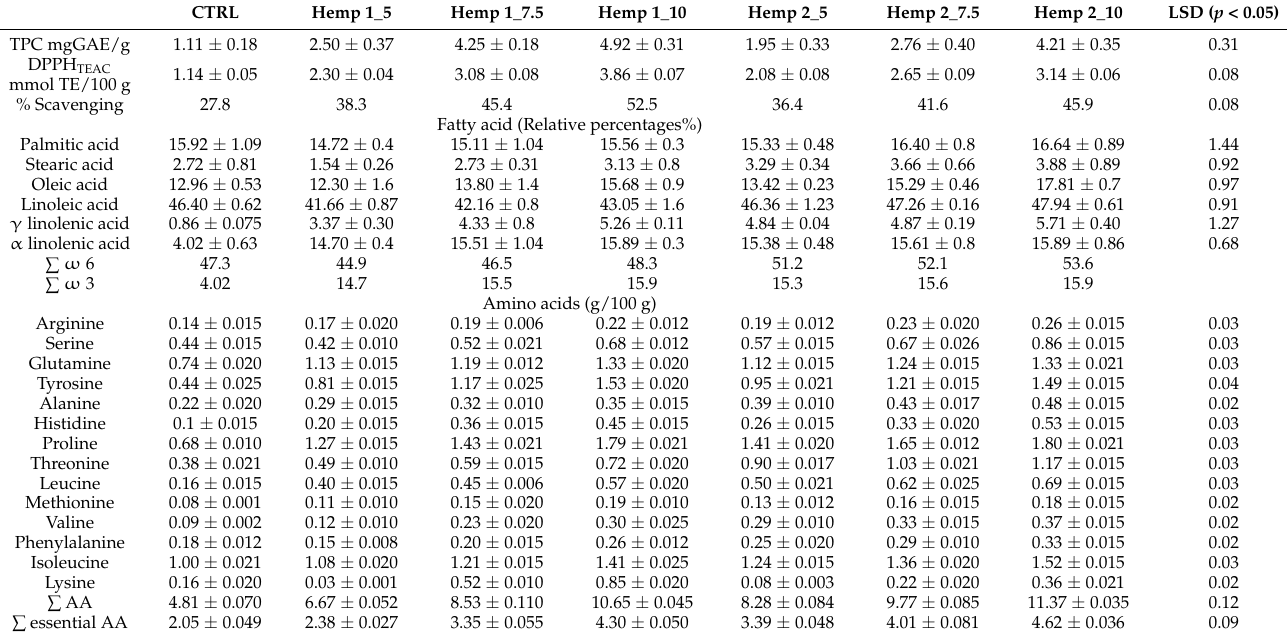
Table 6. Chemical characterization of cooked